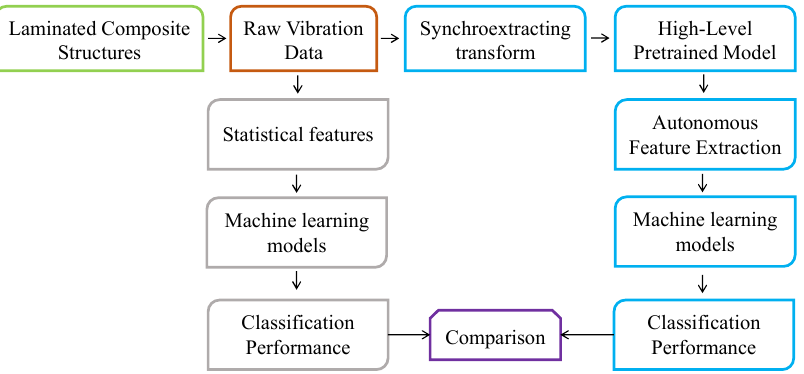
Figure 1. The general workflow of the proposed methodology.